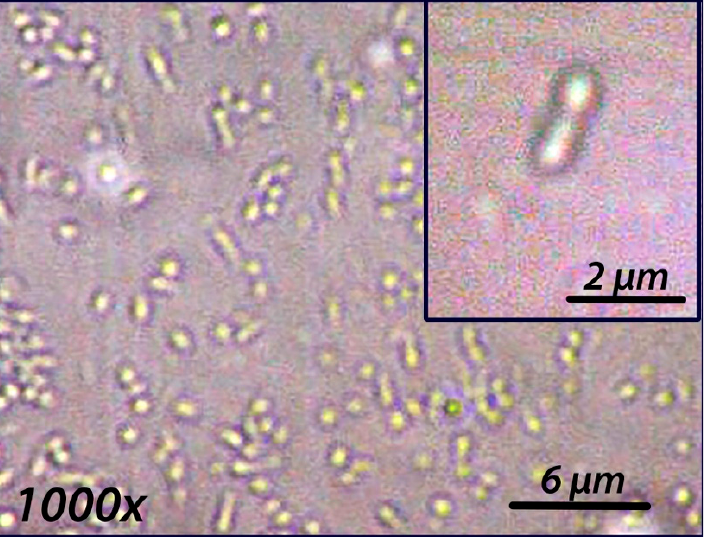
Figure 3. Phase contrast microscopy of Rhodobacter strain M37P at 1000× total magnification. Insert is 2.5× digitally magnified and contrast autocorrected.